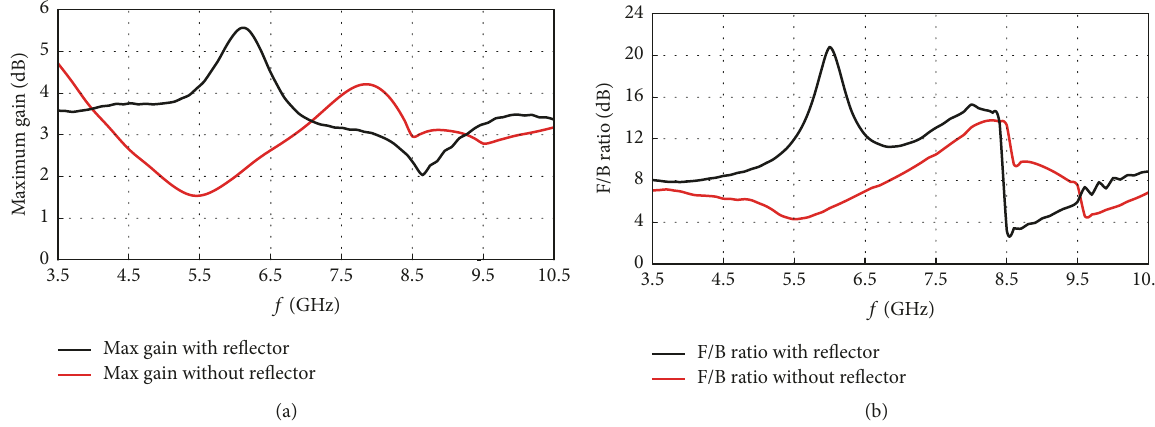
Figure 10: Frequency behaviour of the maximum antenna gain (a) and front-to-back ratio (b). As it can be observed the reflector improves the maximum antenna gain in the frequency range where the main wireless applications, as well as the spectrum of the UWB pulse signals, fall [14]. In addition, it improves the antenna front-to-back ratio, this being beneficial for a larger electrical insulation with the RF circuitry.